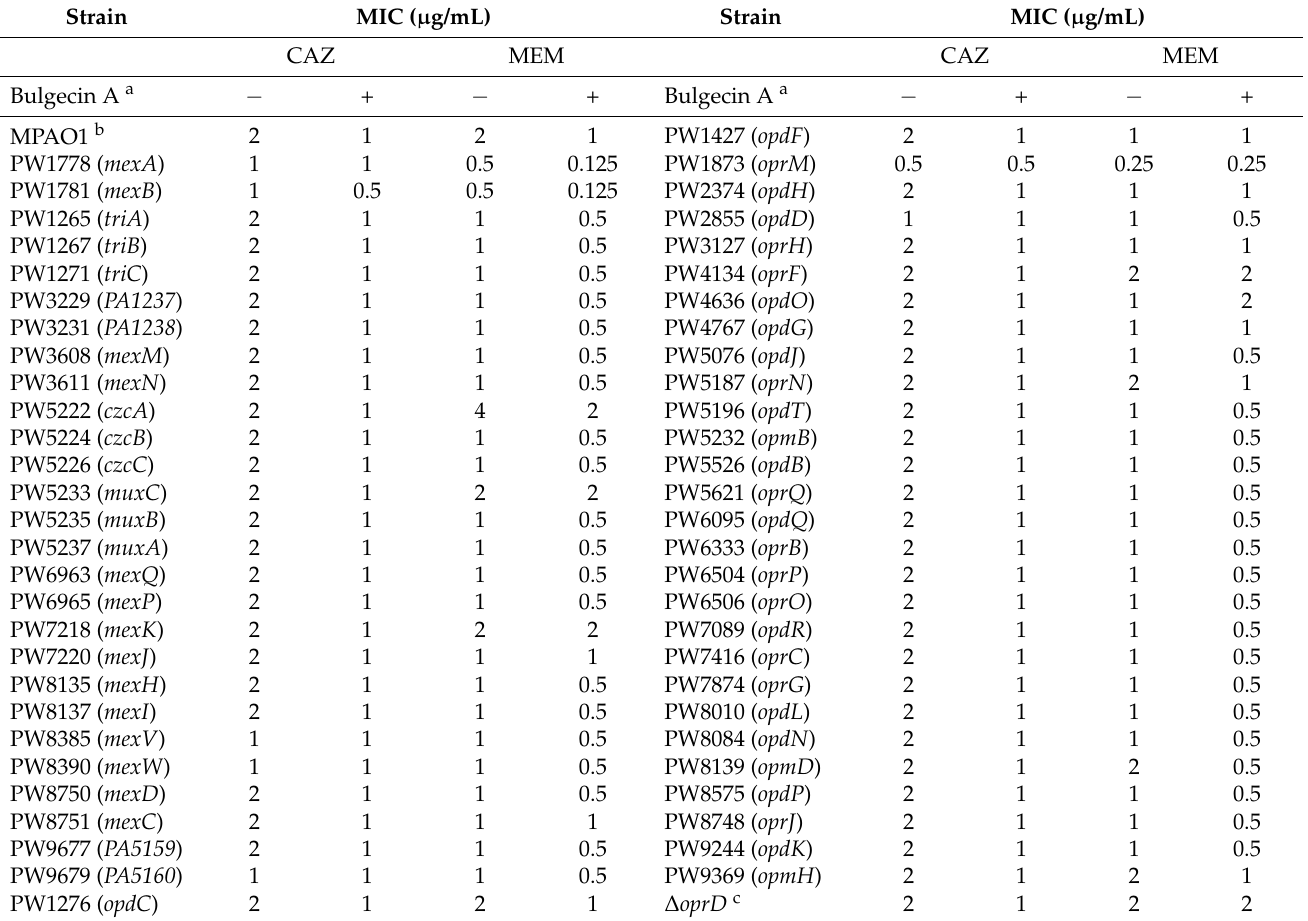
Table A1. Effect of bulgecin A on the MICs of CAZ and MEM against efflux pump- or porin- transposon mutants.